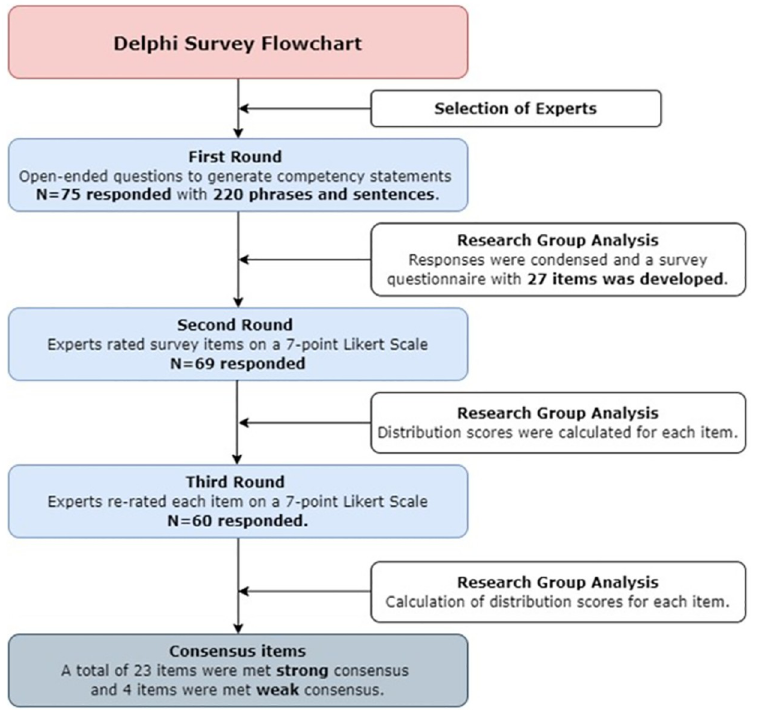
Fig 1. Delphi study